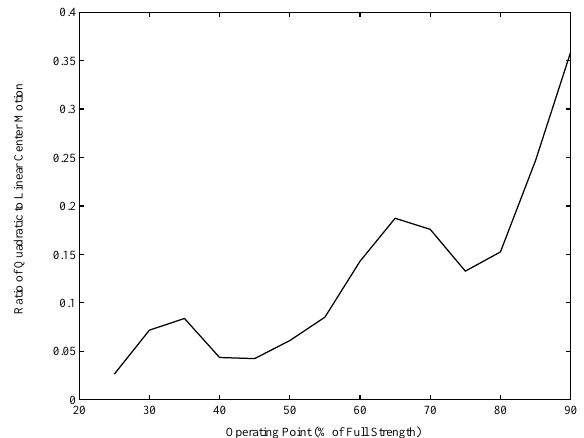
FIG. 8. rms ratio of ¨ x to (cid:2) x for 1000 randomly generated iron- core quadrupoles. Data were generated for five step symmetric scans with D K of